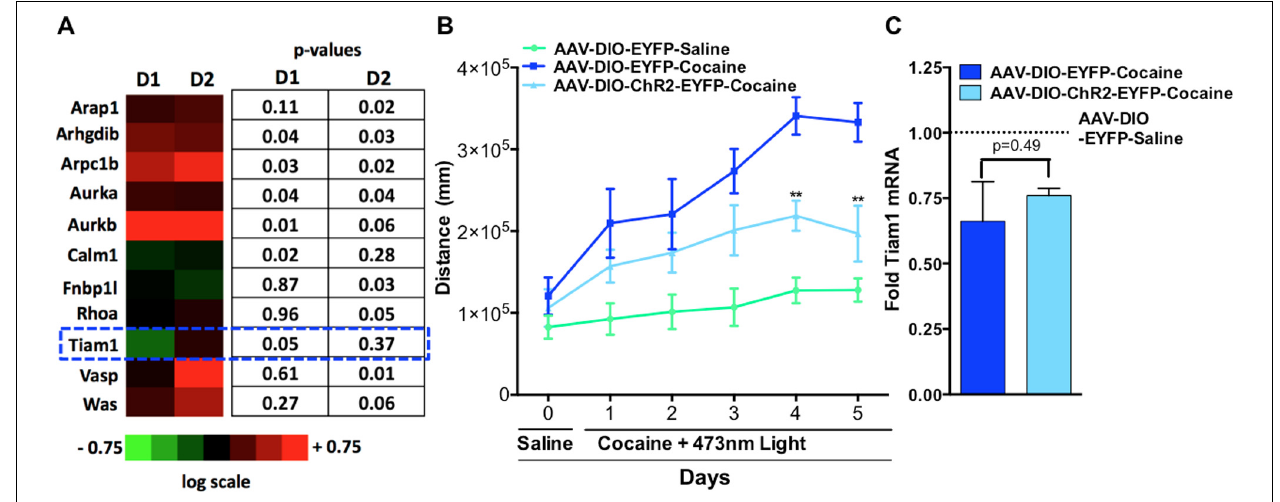
FIGURE 2 | Optogenetic activation of NAc D1-MSNs but not D2-MSNs altersTiam1 levels. (A) D1-Cre or D2-Cre mice expressing AAV-DIO-ChR2-EYFP or AAV-DIO-EYFP in NAc received 5 days of blue light illumination to the NAc ( n = 4 per group) and NAc tissue was used to